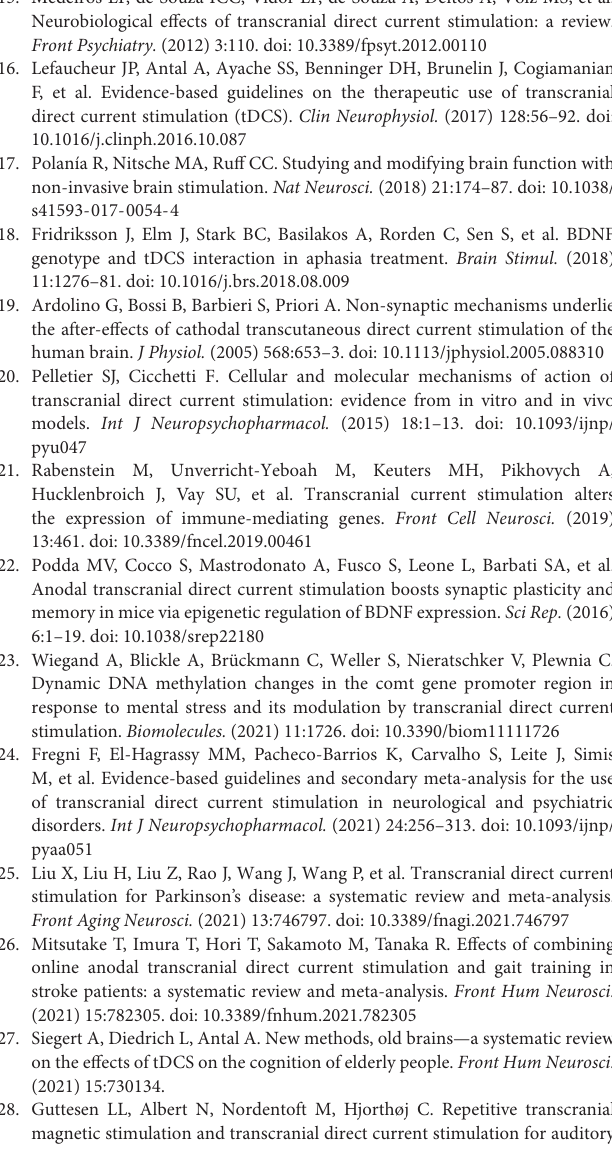
Supplementary Figure 1 | PRISMA 2020 flow diagram for new systematic reviews, which included searches of databases, registers, and other sources [A LiteratureMini-Review of Transcranial Direct Current Stimulation (tDCS) in Schizophrenia]. From: Page MJ, McKenzie JE, Bossuyt PM, Boutron I, Hoffmann TC, Mulrow CD, et al. The PRISMA 2020 statement: an updated guideline for reporting systematic reviews. BMJ 2021;372:n71. doi: 10.1136/bmj.n71. For more information, visit http://www.prisma-